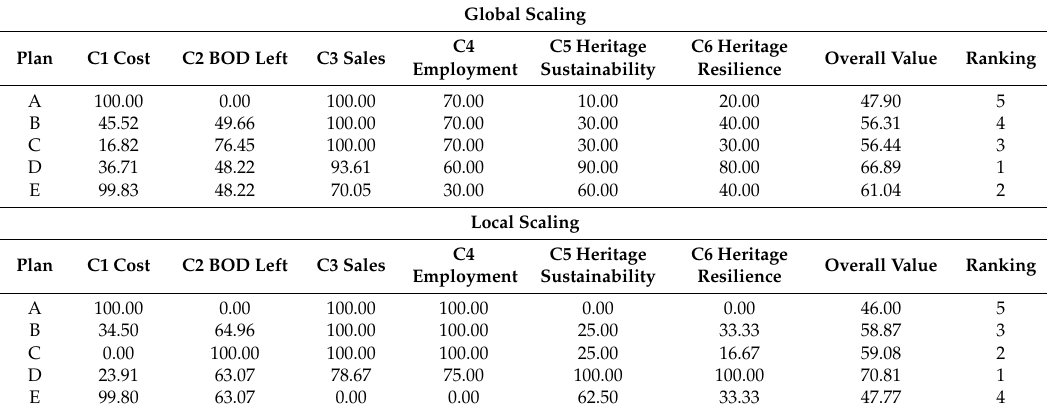
Table 6. Standardised scores of the alternatives (the more the better), with global scaling and local